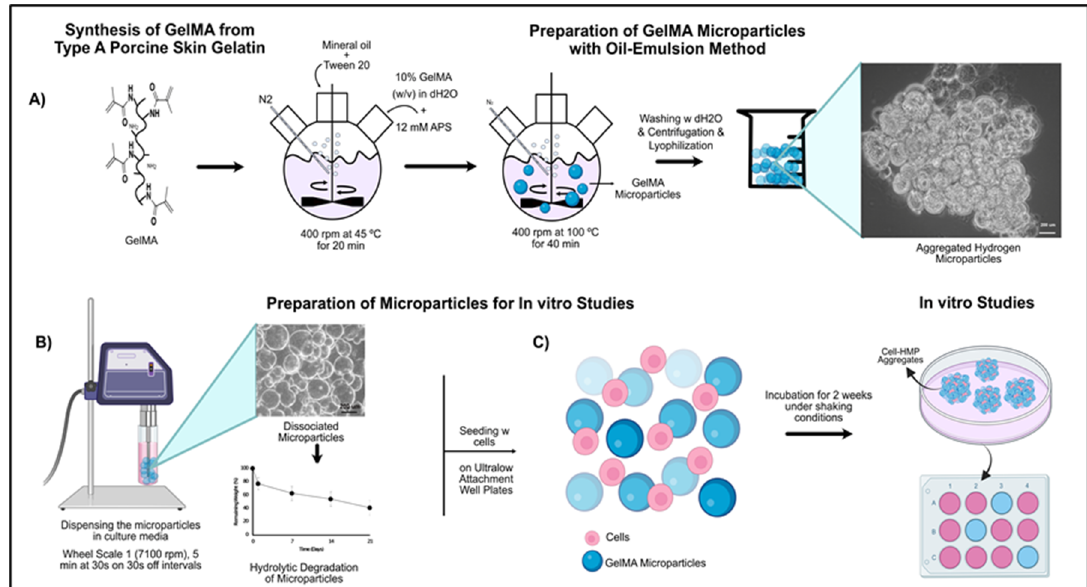
Figure 1. Experimental approach: ( A ) GelMA HMPs were synthesized from type A porcine skin gelatin using oil – water emulsion method followed by thermal crosslinking at 100 °C followed by lyophilization. ( B ) Aggregated HMPs were dissociated via sonication. ( C ) Cell-seeded HMPs were cultured on ultralow attachment plates for 2 weeks with constant shaking.